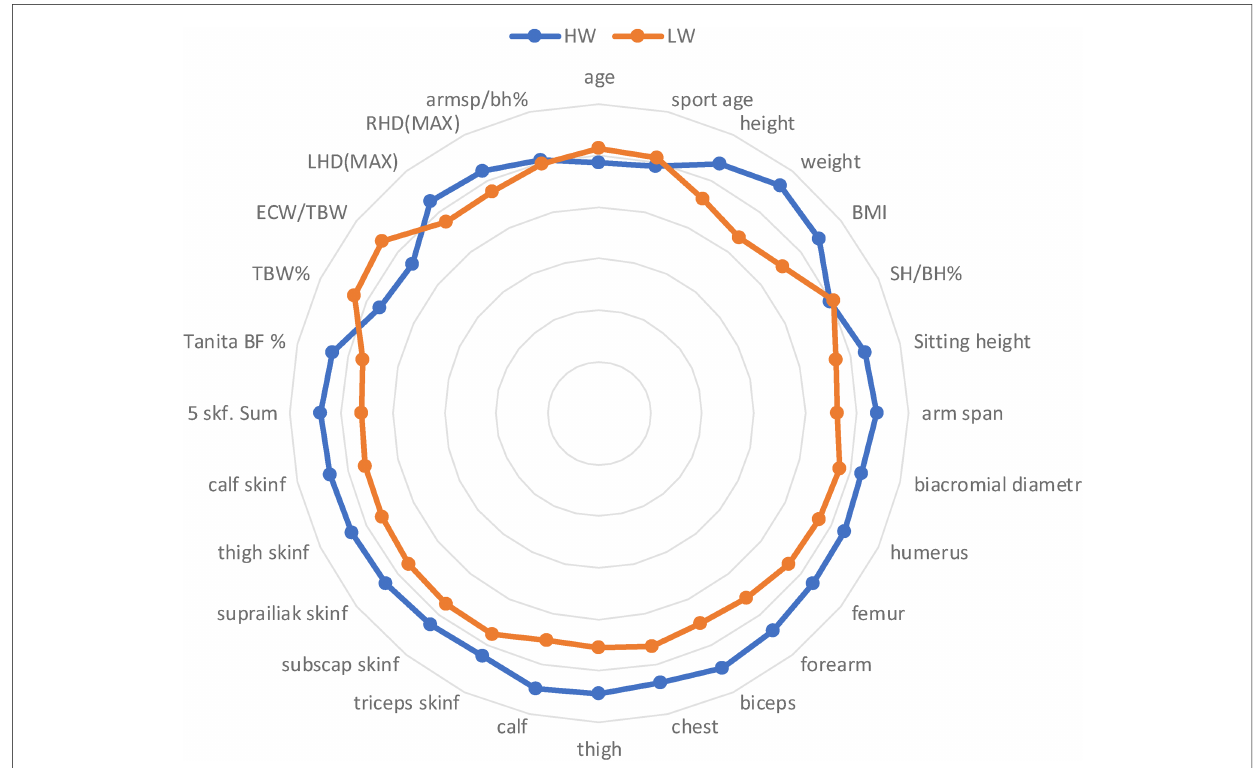
FIGURE 3 Radar graph with markers to present intergroup differences in